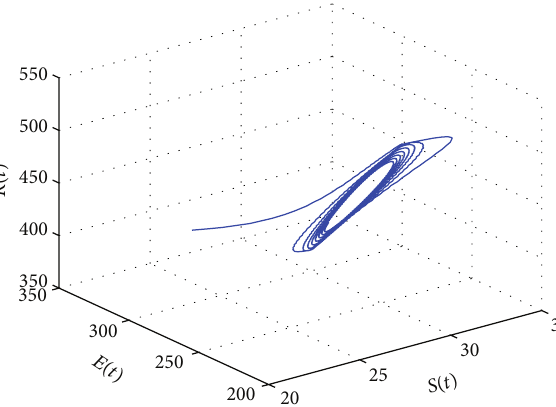
Figure 8: The phase plot of the states 𝑆 , 𝐸 , and 𝑅 for 𝜏 2 = 67.5000 > 52.4927 = 𝜏 20 .